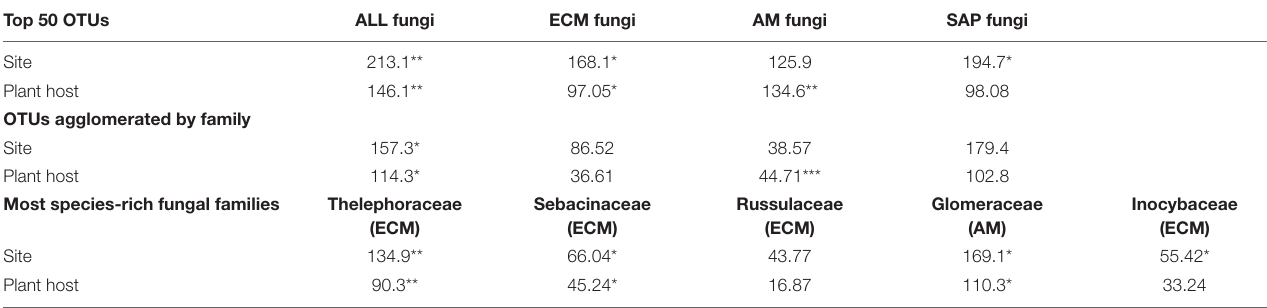
FIGURE 2 | Non-metric multidimensional scaling (NMDS) ordination of fungal community composition of root and soil samples of Juniperus deppeana (in red) and Quercus rugosa (in blue) seedlings between sites (native = square, mixed = circle, disturbed = triangle) based on Raup-Crick dissimilarity distances. According to PERMANOVA, (A) the global fungal community (ALL) varied significantly between sites ( R 2 = 0.55***) and plant hosts ( R 2 = 0.43***), but not sample type (stress = 0.25); (B) Ectomycorrhizal (ECM) fungal communities varied significantly between sites ( R 2 = 0.23**) but not plant hosts or sample type (stress = 0.25); (C) Arbuscular mycorrhizal (AM) fungal communities did not vary significantly between sites, plant hosts or sample type (stress = 0.12); (D) Saprophytic (SAP) fungal communities varied significantly between sites ( R 2 = 0.31**), plant hosts ( R 2 = 0.32***) and sample types (0.16683*) (stress = 0.26). Significance levels = * P ≤ 0.05, ** P ≤ 0.01, and *** P ≤ 0.001. TABLE 3 | DEV values from multivariate analyses of deviance estimating the effect of site and plant host on the 50 most frequent OTUs, agglomerating OTUs by fungal families, and for the five most species-rich families in root samples. Top 50 OTUs ALL fungi ECM fungi AM